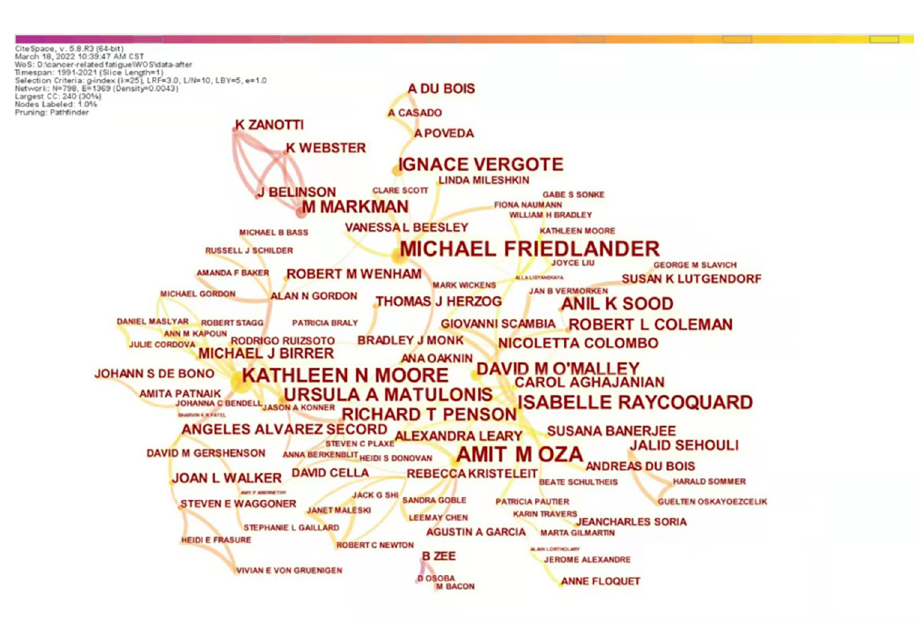
Fig 4. Map of author network related to cancer-related fatigue in ovarian cancer survivors.